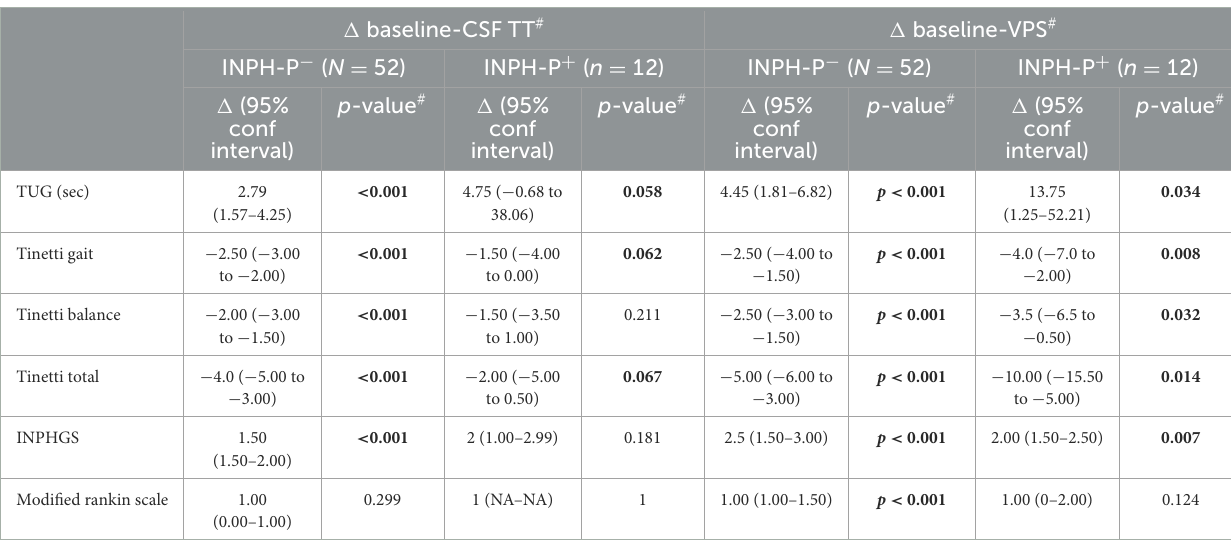
TABLE 3 Comparison of differences between parameters at presentation/ baseline vs. at 72h after the tap test and at presentation/baseline vs. at 6 months post-VPS for NPH-P + and NPH-P −